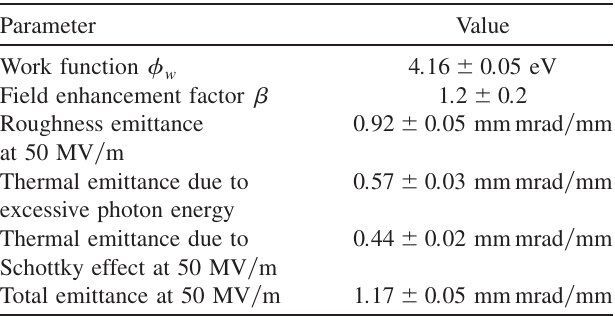
EXPERIMENTAL INVESTIGATION OF THERMAL . . TABLE III. Cathode parameters extracted from thermal emit- tance model fitting. Parameter Value Work function (cid:2) w